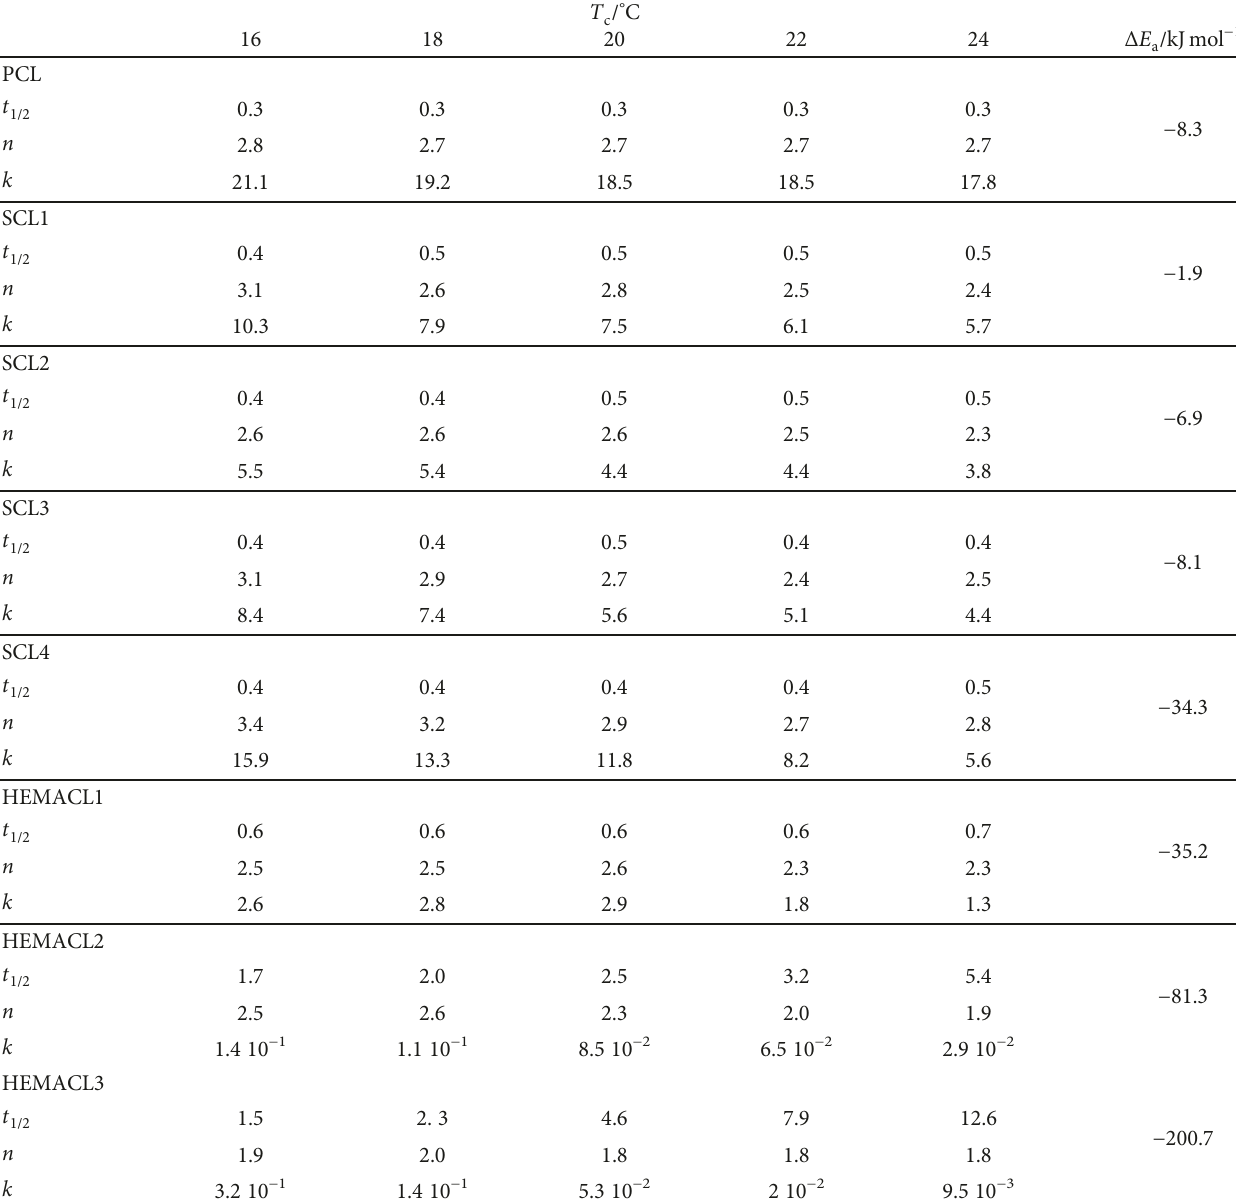
) for linear PCL, SCL#, and HEMACL# c